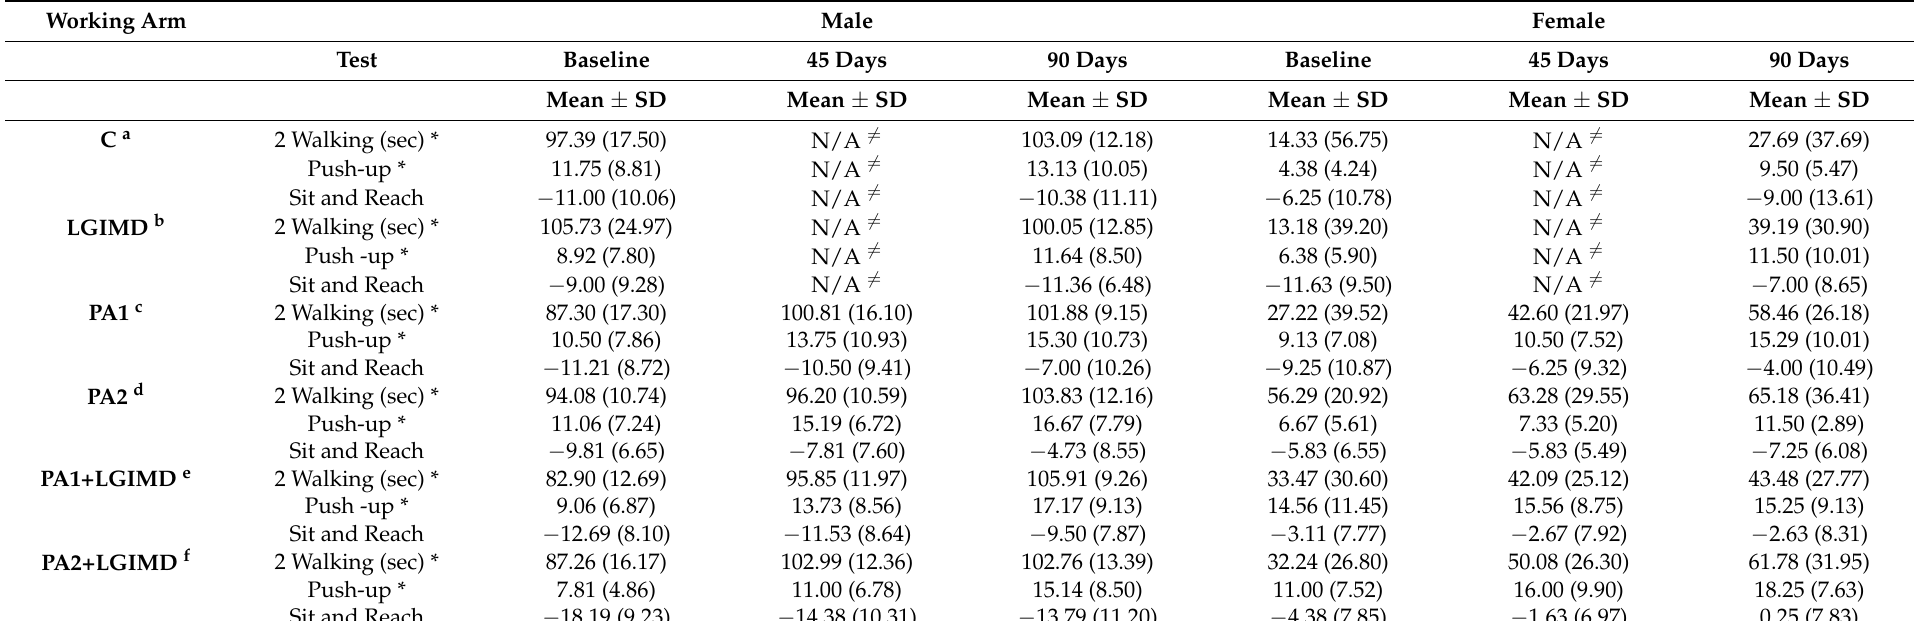
Table 3. Field Fitness Test Results by Gender and Time. NutriAtt Trial, Castellana Grotte, 2015–2016. Working